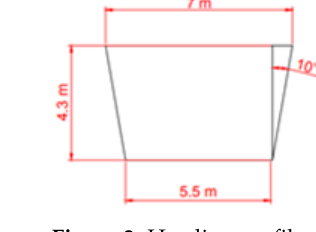
Figure 2. Heading profile.